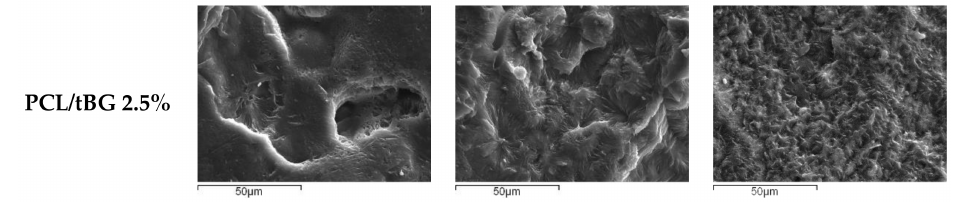
Figure 12. SEM micrographs of PCL and its nanocomposites after 3, 6 and 9 days of enzymatic degradation.